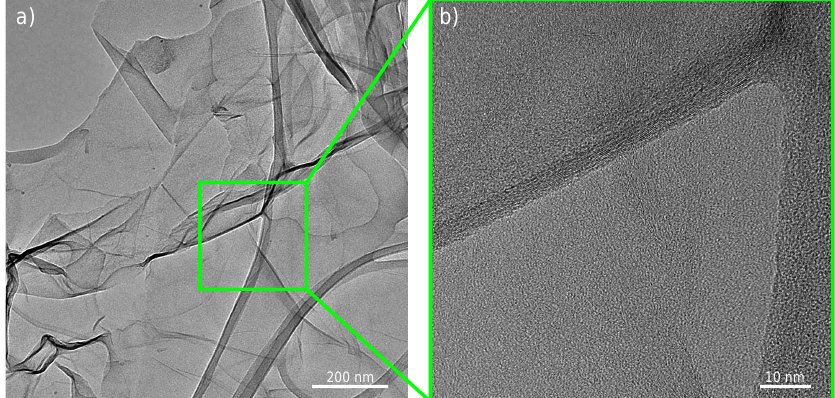
Figure A17. TEM images for Avan2 at ( a ) low magnification and ( b ) high magnification.